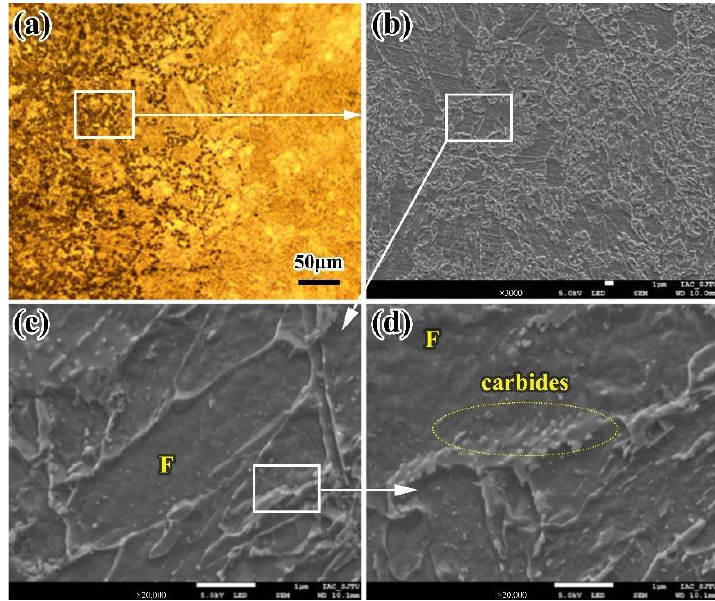
Figure 7. Microstructure of the OTZ of the LBW joint ( a ) Microstructure in the OTZ ( b ) SEM in the OTZ ( c ) Polygonal ferrite ( d ) Carbides on ferrite grain boundaries. F: ferrite.